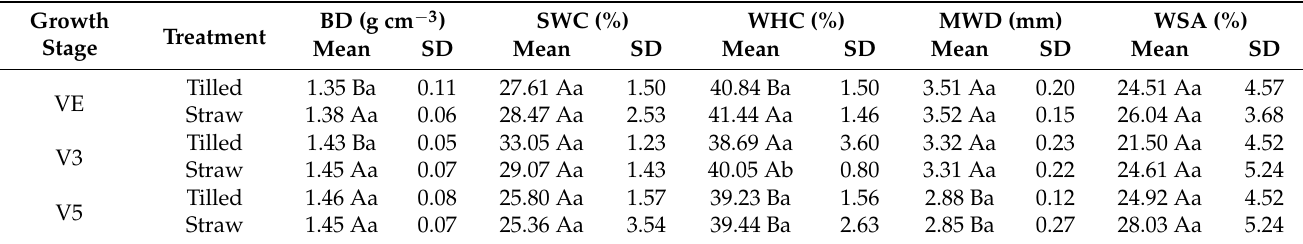
Table 2. Results of two-way ANOVA analysis considering soil properties. Different letters after mean values in the columns represent significant difference at p < 0.05. Capital letters show statistical difference between stage growth. Lower case letters show statistical differences between